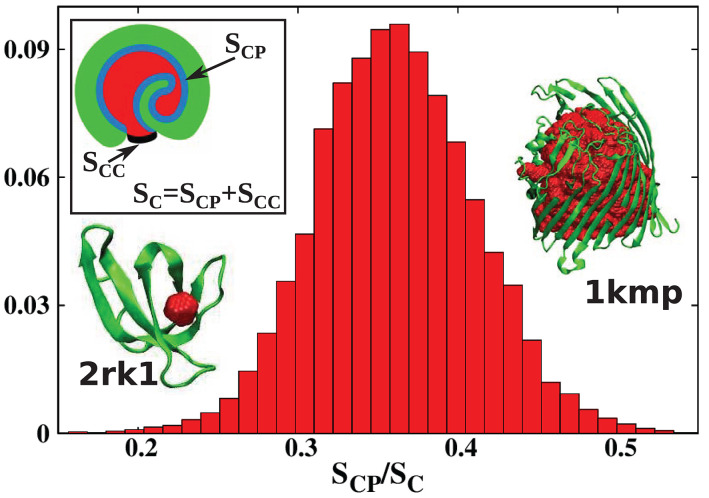
Histogram of the values of the parameter s = SCP/SC obtained in this survey. The s parameter defines the degree of cavity closure. The mean(standard deviation) of this parameter is s¯(σ)=0.36(0.05). Pockets correspond to s<s¯-3σ which means s < 0.21. The inset shows a schematic representation of SCP (blue) and SC (blue combined with black). The protein with the most buried cavity is chain A of the iron(III) dicitrate transport protein Feca [PDB: 1kmp (90.28 kDa)]. The protein with the most open cavity considered in this work is chain A of DHFR R67 Complexed with NADP and dihydrofolate [PDB: 2rk1 (8.27 kDa)].